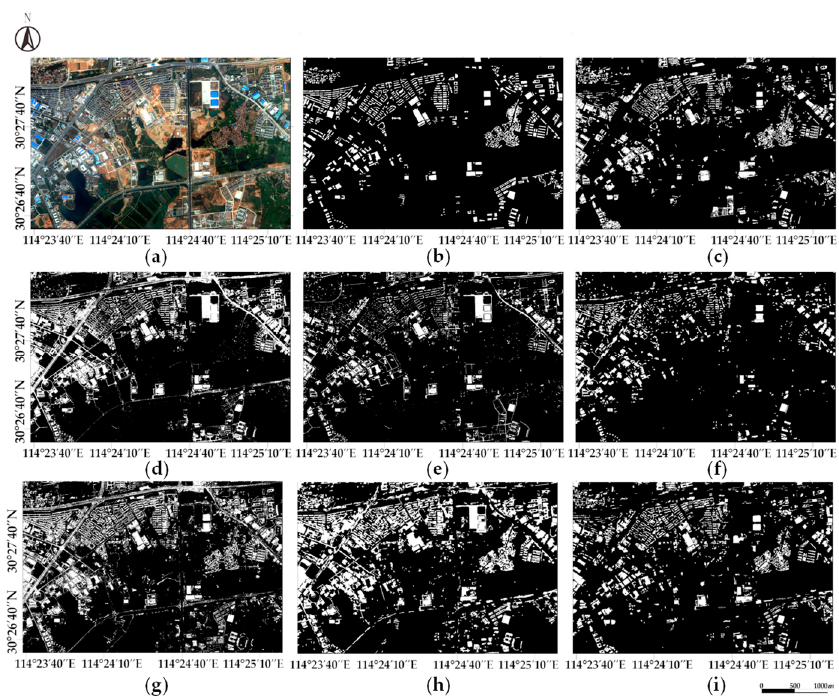
Figure 8. Building feature extraction results for Dataset 3: ( a , b ) the RGB image and the ground truth map; ( c ) the building detection result of the MBI; ( d – f ) the building maps with the results of the pixel-based SVM, DMP-SVM, and object-oriented SVM, respectively; ( g , h ) the building detection results of DMP-RF and object-oriented RF; ( i ) the results of the proposed framework. Table 5. Building detection accuracies of the test datasets.